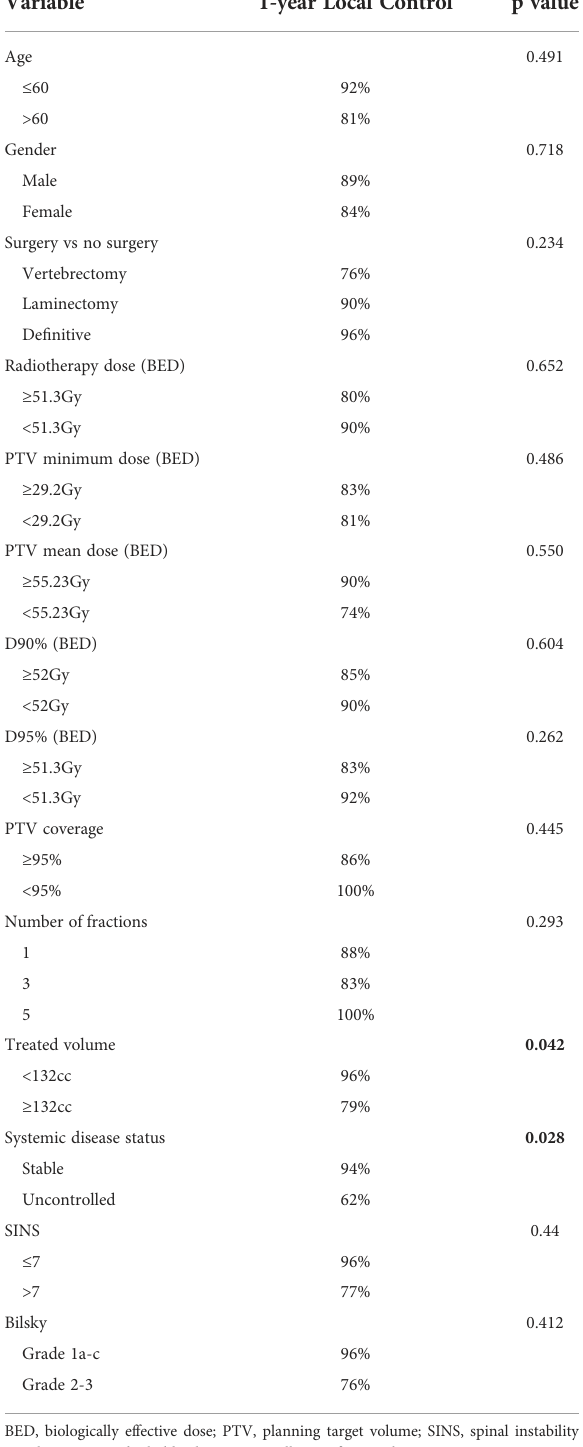
TABLE 2 Univariate analysis examining for variables associated with increased likelihood of local failure using a proportional hazards